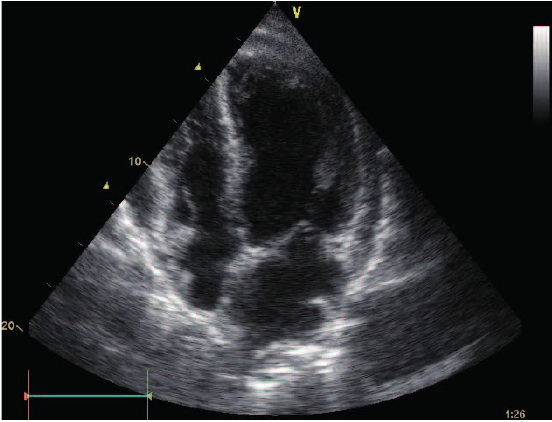
Figure 7. Follow-up echocardiographic examination.